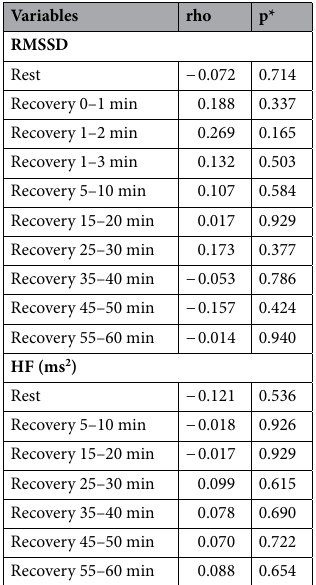
Table 2. Correlation between HRV (RMSSD and HF) and birth weight. RMSSD root-mean square of differences between adjacent normal RR intervals, HF high frequency.